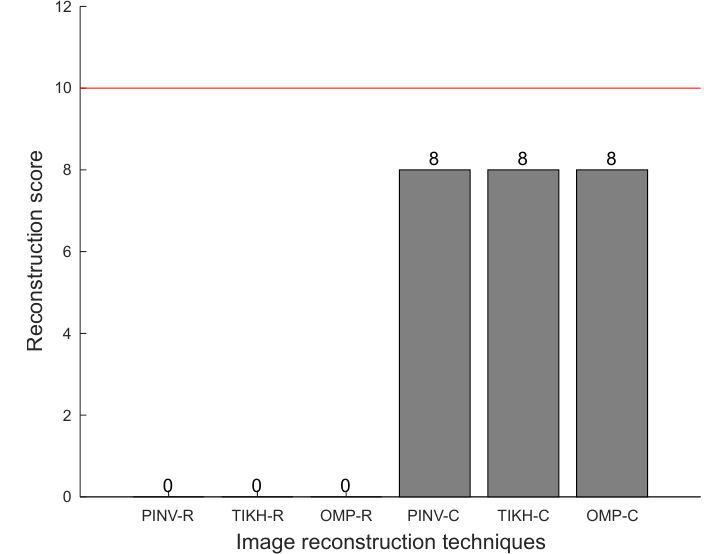
Figure 15. Reconstruction scores with three obstacles in the environment.